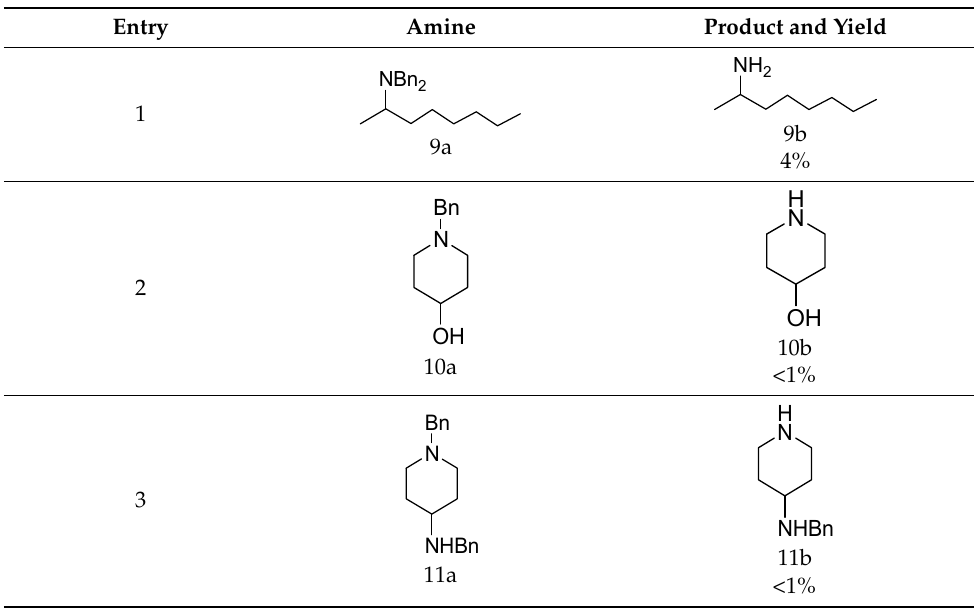
Table 4. Laccase-catalyzed tertiary amine benzyl removal of substrate.